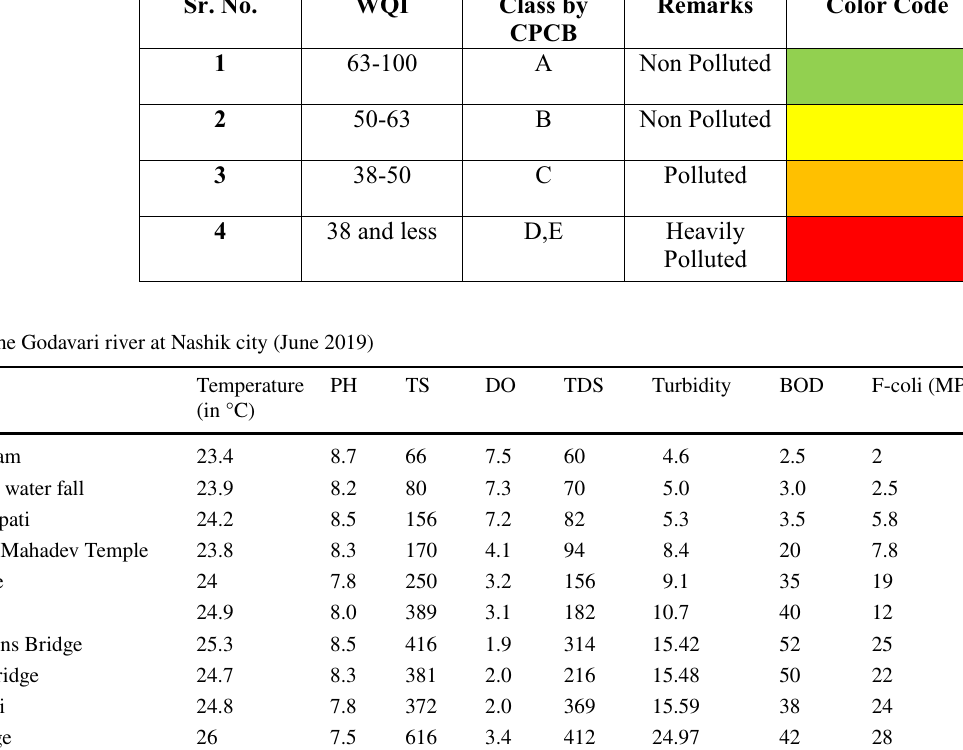
Required desirable limits—as per standards prescribed For Drinking Water by Bureau of Indian Standards, 2002 (BIS)